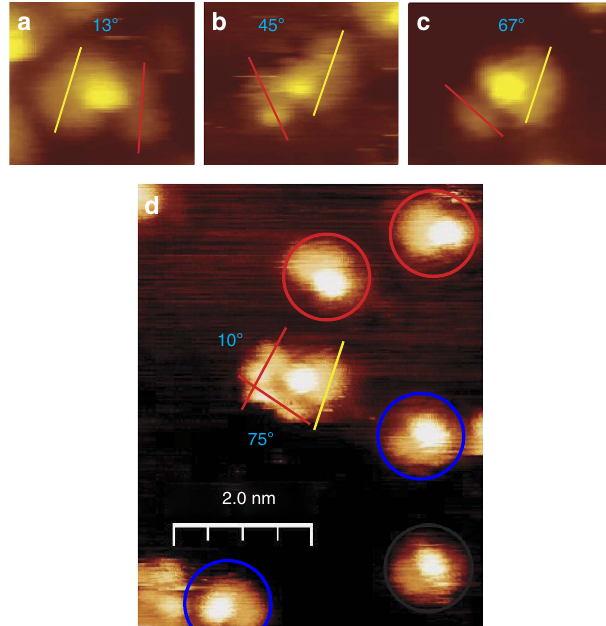
Figure 3 | Example images of docking complexes formed between MP and NEA on Pd(111). The figure shows high-resolution STM images of the docking complexes identified from co-adsorbed NEA and MP on Pd(111) at 120K. In most cases, a single MP molecule coordinates to NEA. Examples of such docking complexes are shown in a – c and are characterized based on the angles between the long axes of the naphthyl group (indicated as yellow lines) and the MP molecule (indicated as red lines). The examples shown, which appear most often, have dihedral angles of B 13 (cid:2) ( a ), 45 (cid:2) (b ) and 67 (cid:2) ( c ). In rare cases, shown in d , which displays a wider scan area, two MP molecules can coordinate to a NEA molecule. This figure also illustrates that the docking complexes are well separated from isolated NEA molecules, which are highlighted in red (exo conformer) and blue (endo conformer).